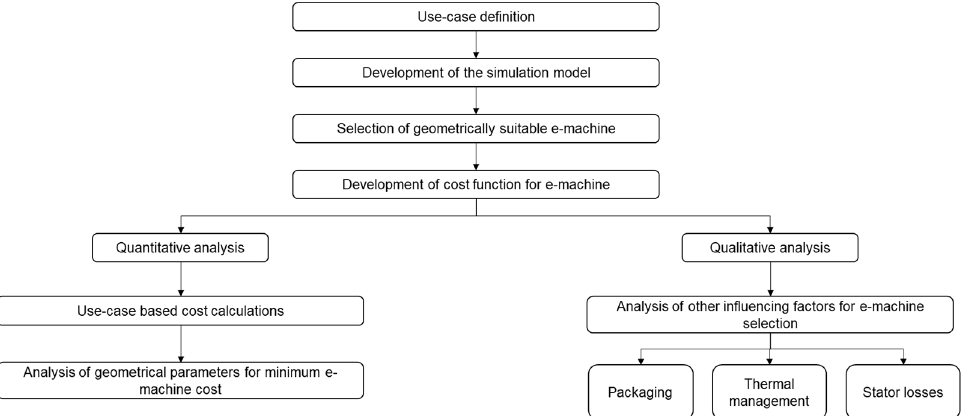
Figure 1. Overview of steps followed for methodology development.